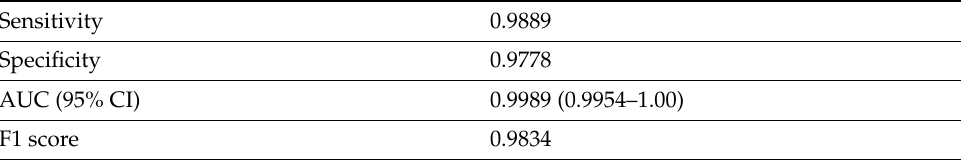
Table 2. Evaluation of deep learning classification model.